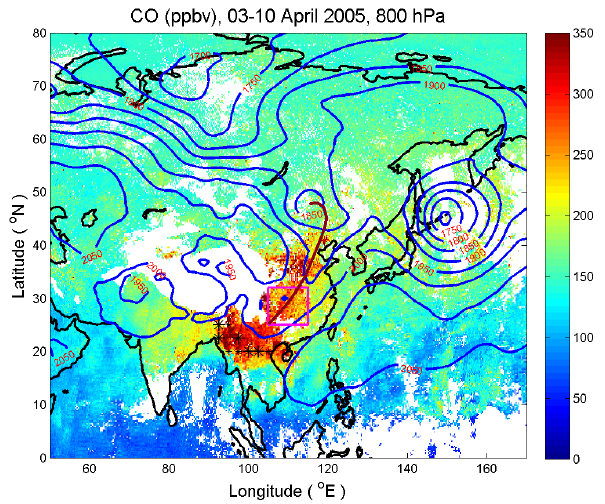
Figure 13. MOPITT CO mixing ratio at 800hPa from 3 to 10 April 2005, overlaid with the geopotential height at 850hPa on 9 April 2005 at 00:00 UTC in blue contour and with a front as a brown solid line. The large and small stars denote daily mean fire counts of 100–200 and over 200 per 2.5 ◦ × 2.5 ◦ grid area during the period, respectively. The boxed area was identified as a major CO source region from the FLEXPART simulation (see text for detail).